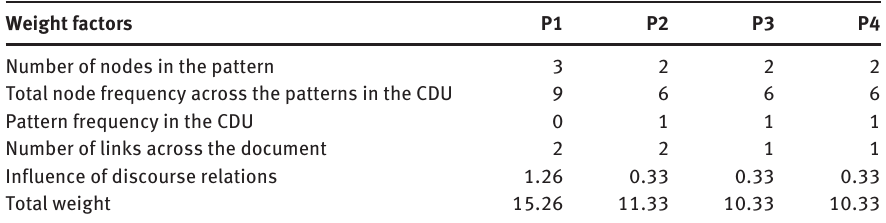
Table 2. Weight Factors for the